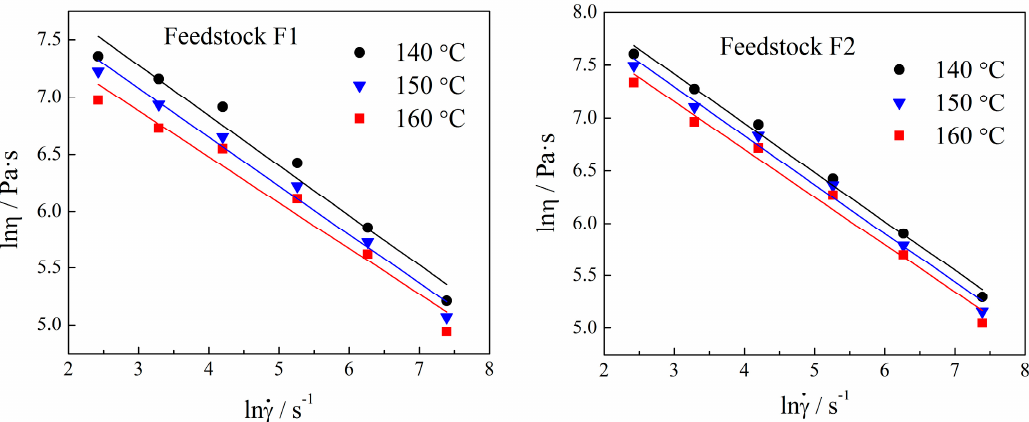
Figure 3. Plot of the double logarithm of viscosity versus the shear rate at different temperatures. Table 2. The n values of feedstocks at different temperatures.